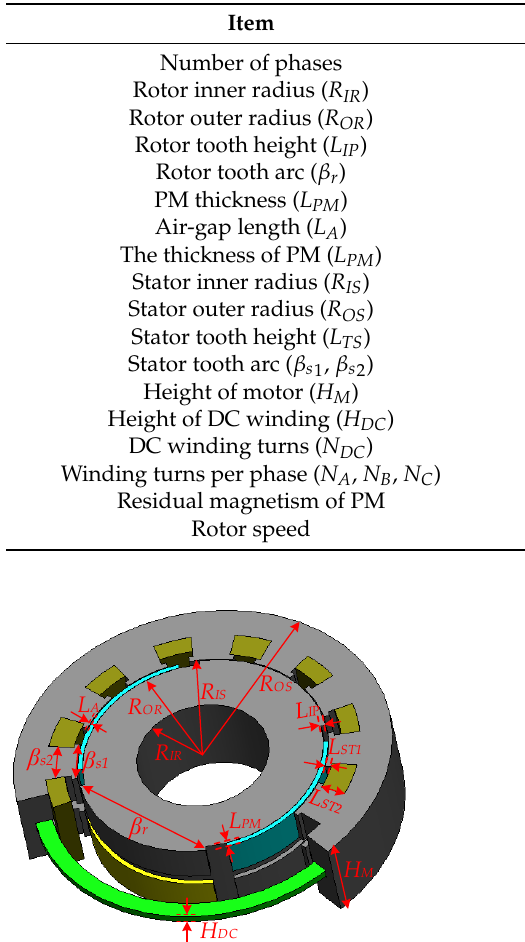
Table 2. Machine parameters.